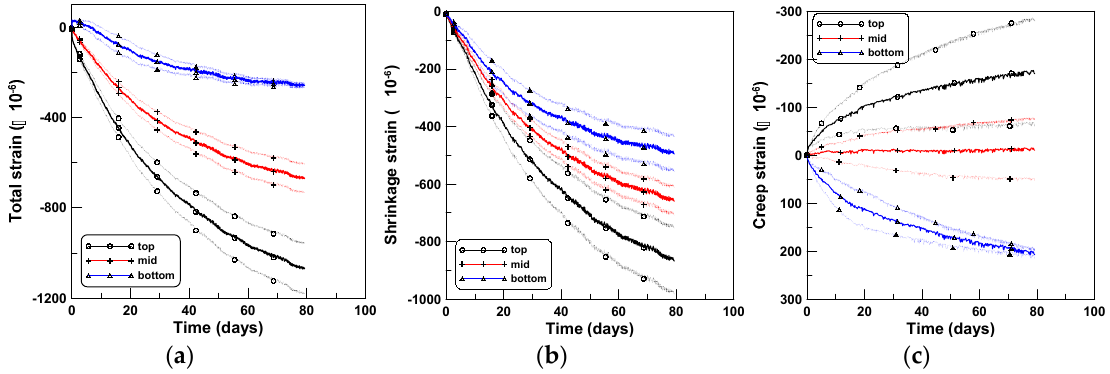
Figure 7. Strains at top, mid, and bottom surfaces (TP-1): ( a ) total, ( b ) shrinkage, and ( c ) creep.